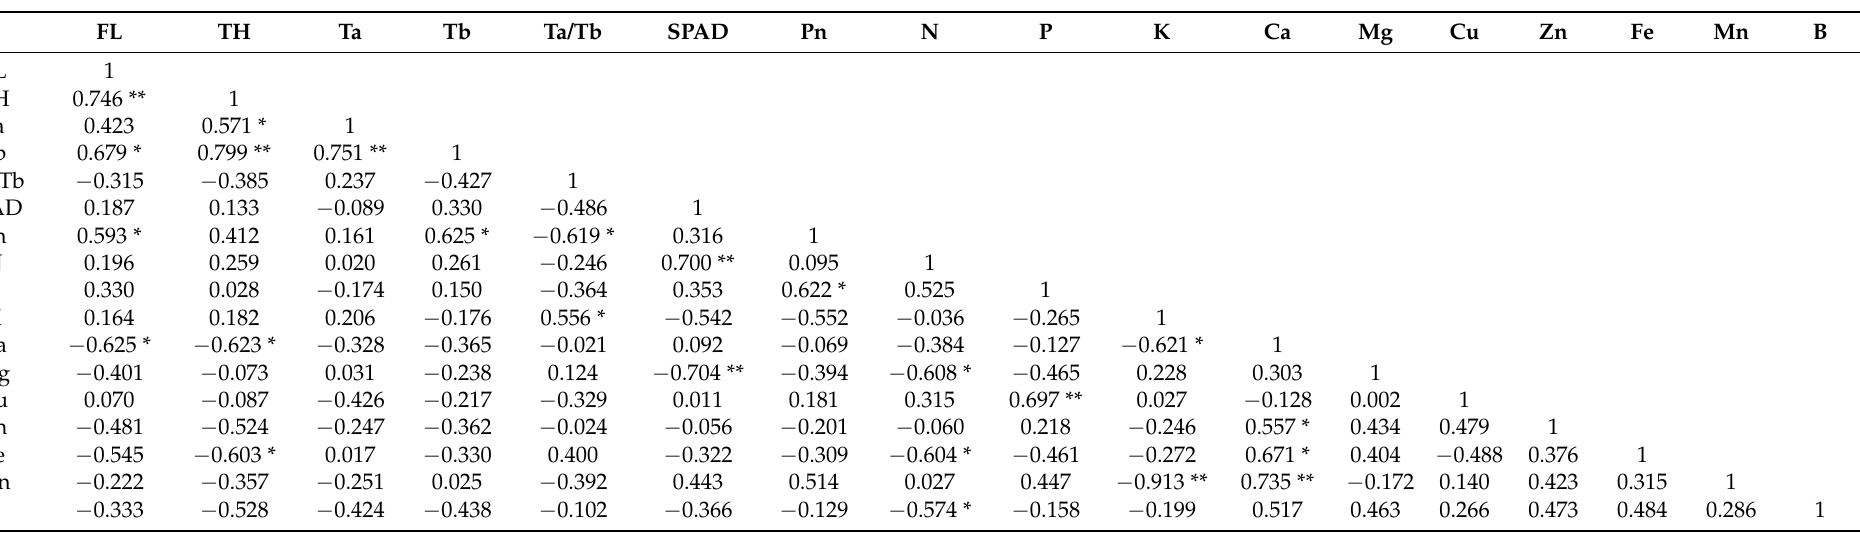
Table 6. Correlations between measured